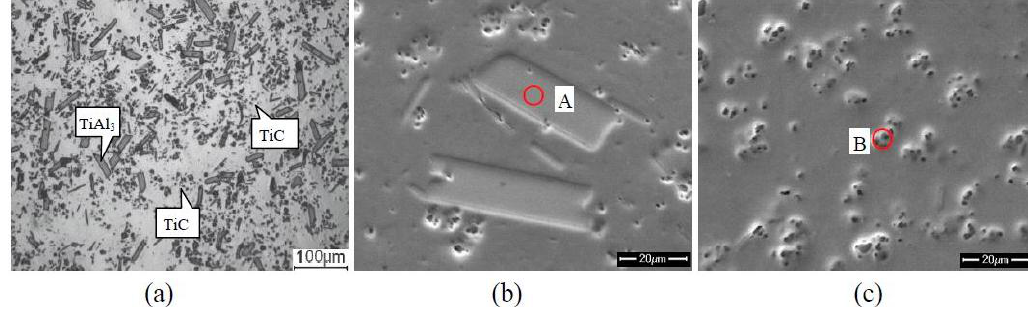
; and ( c ) SEM image of 3